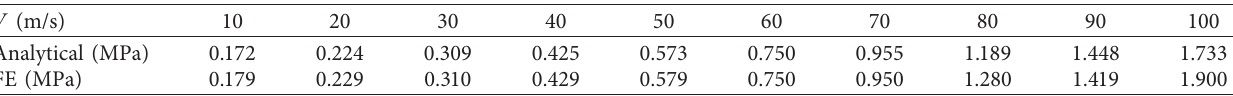
Table 4: The dynamic collapse stress of DHHs under uniaxial compression in the z direction, N � 5 and ρ �